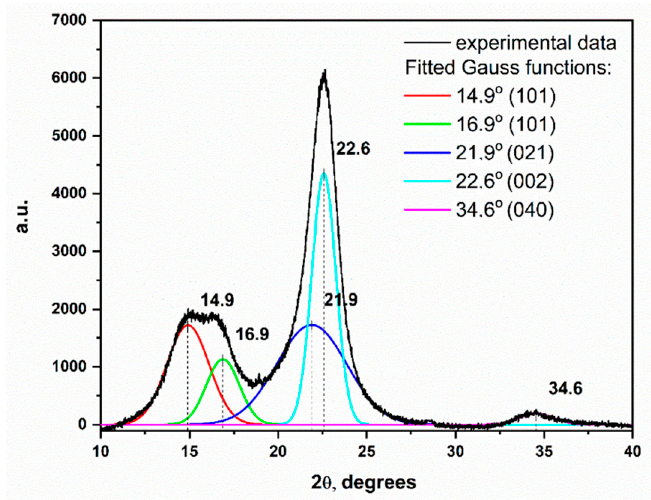
Figure 5. XRD pattern of model cellulose (Sigmacell) with fitted Gauss functions.